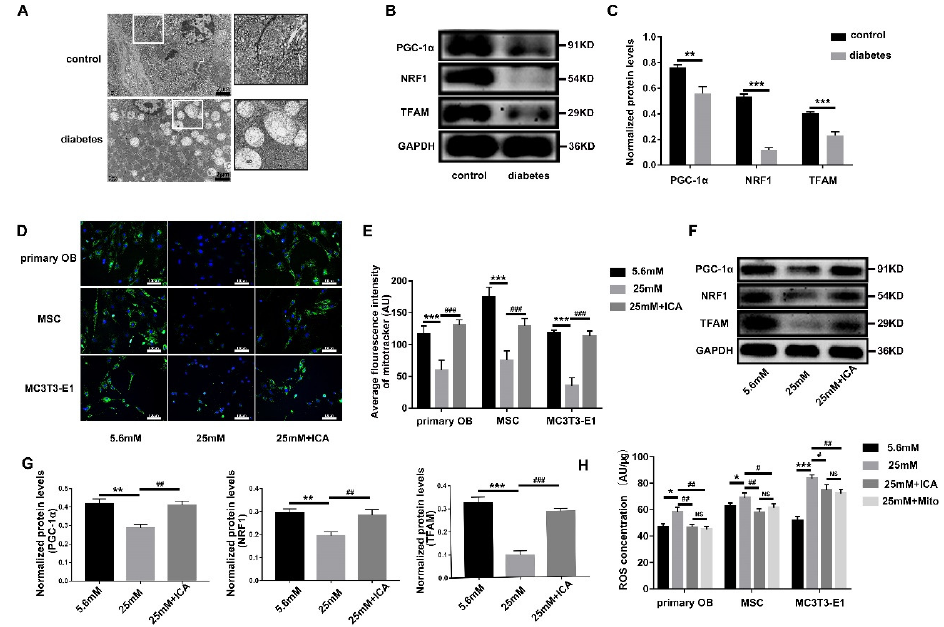
Figure 6. ICA inhibits ROS to maintain functional homeostasis of mitochondria and primary cilia. ( A ) Transmission electron microscope observed pancreatic tissues (scale bar: 2 µ m, white box: mitochondria). ( B ) Western blot detected the expression of PGC-1 α , NRF-1 and TFAM in the femoral protein. ( C ) Quantitative analysis the level of protein expression in ( B ). Three kinds of osteoblast cells were induced for 3 days, ( D ) immunofluorescence image of Mito-Tracker Green staining active mitochondria (green), DAPI staining the nucleus (blue), scale bar: 100 µ m. ( E ) Quantitative analysis average fluorescence intensity of ( D ). ( F ) Extract total cell protein of MC3T3-E1, Western blot detected